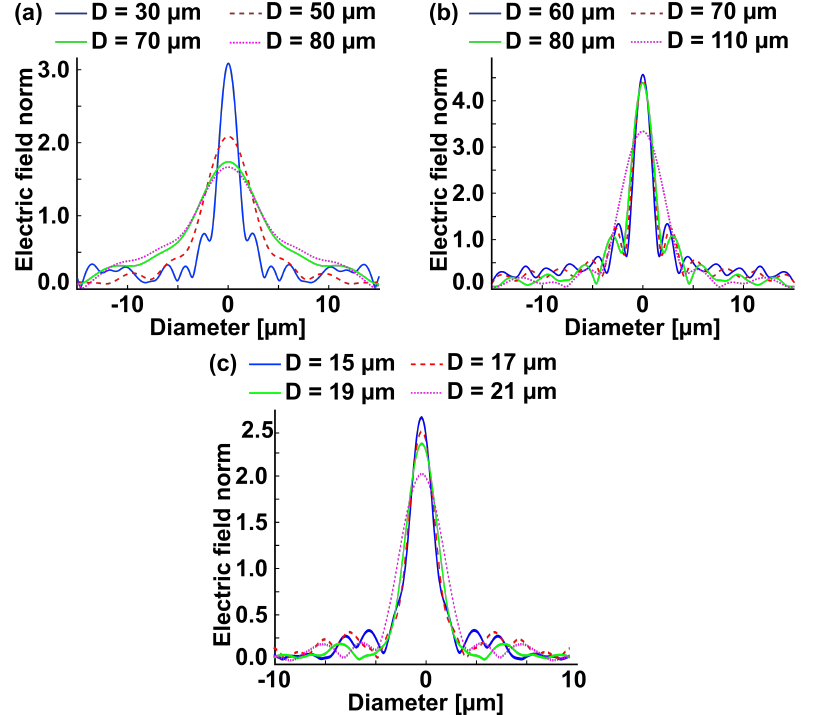
Figure 3. Electric field |E| profile on the PJ planes. The different colors represent the different base diameter D of the microlenses for ( a ) a 20/125 silica fiber ( h = 26 µm, W 0 = 1.10, NA = 0.22). ( b ) a 50/125 silica fiber ( h = 36 µm, W 0 = 0.7, NA = 0.22). ( c ) a 10/125 silica fiber ( h = 14 µm, W 0 = 1.1, NA = 0.12). Fundamental mode excitation at λ = 1064 nm.